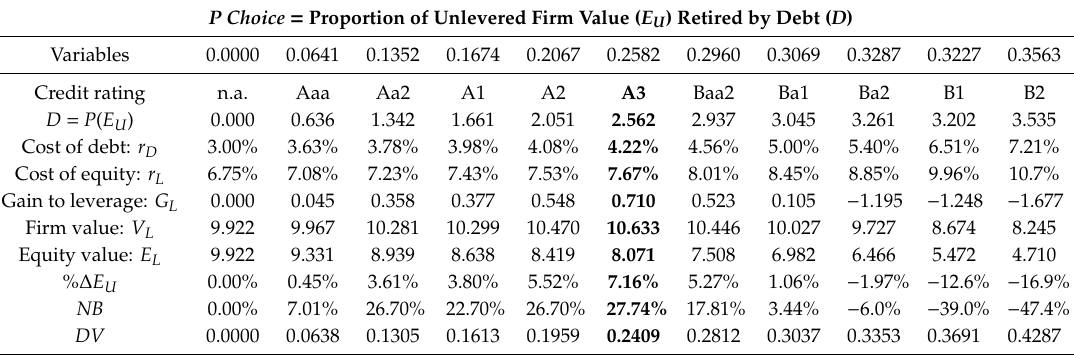
Table to Accompany Appendix B: Pass-through Outputs with